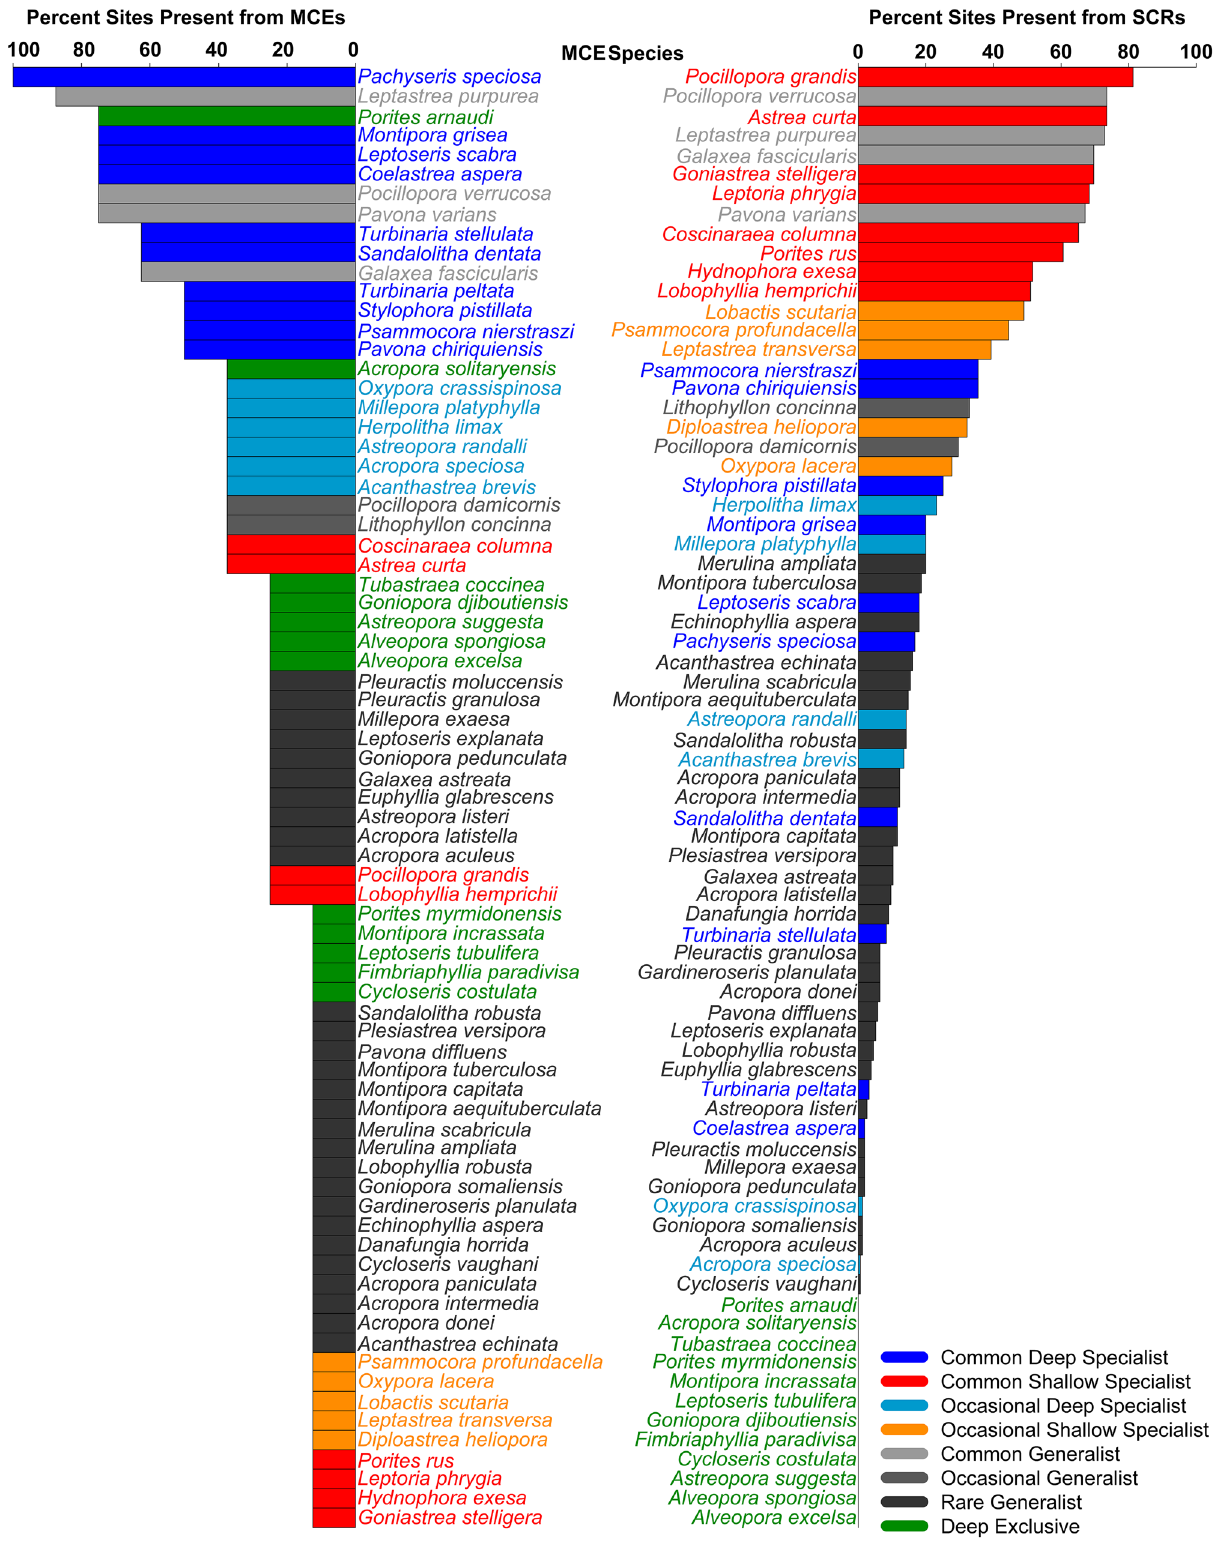
Figure 8. MCE species and the commonness across MCE sites compared to SCR sites. Color coding highlights the categorization of individual species as common, occasional, or rare and as a specialist or